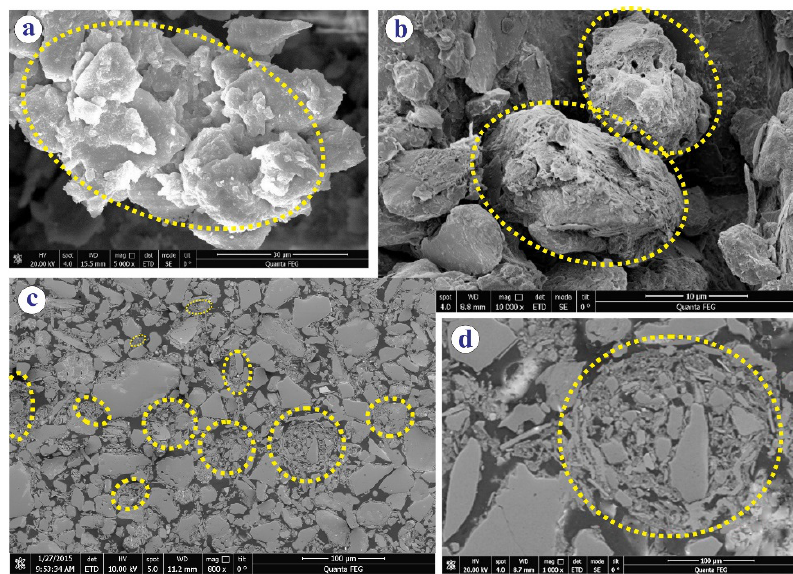
Figure 1. Aggregate in loess: ( a ) Single aggregates at 5000 times magnification; ( b ) At a magnification of 10,000 times, the aggregate has many small size flaps or plate-like viscosities distributed on the surface and inside, and a large number of pores are inlaid inside; ( c ) The aggregate of different size can be seen in the loess samples with 800 times of grinding image; ( d ) The aggregate is magnified 1000 times.